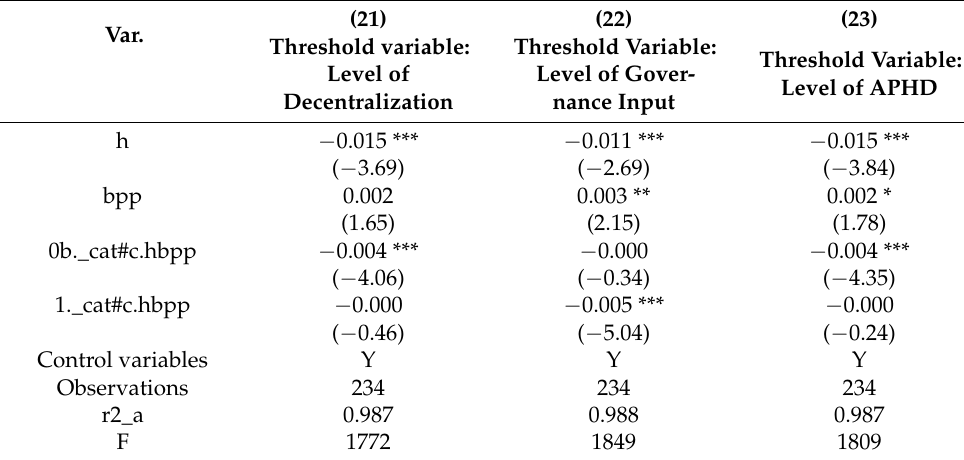
Table 7. The impact effect estimation of threshold